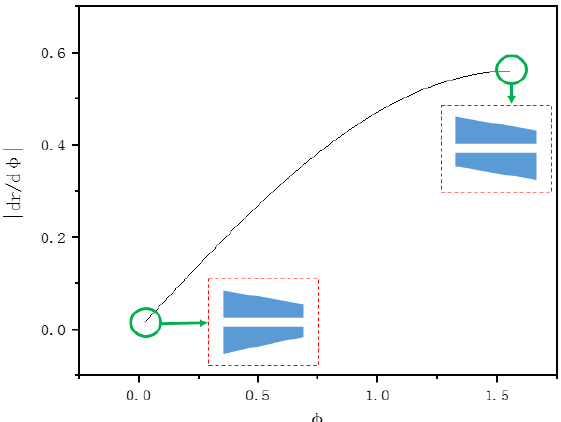
Figure 5. The change rate of r relative to φ under different angles between the two optical wedges.